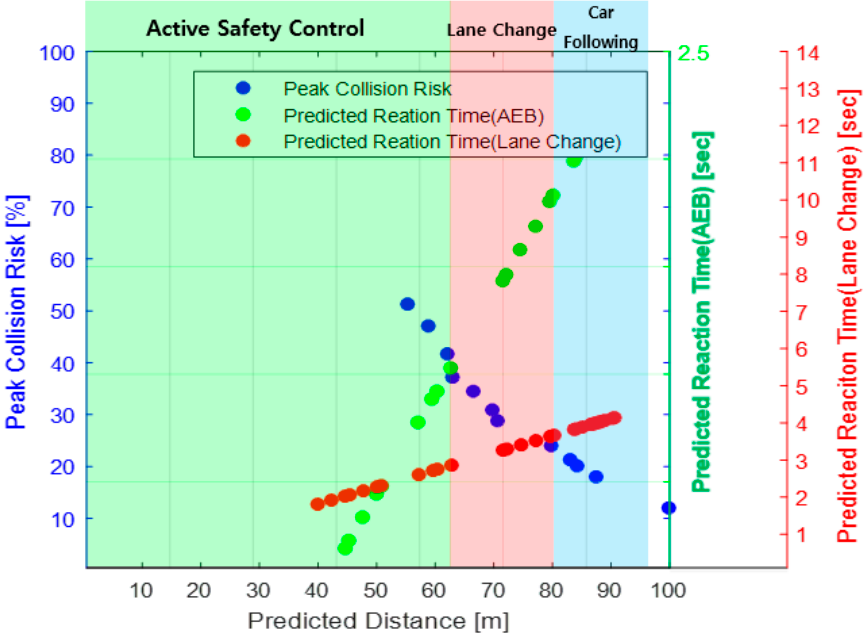
Figure 5. Human Centered Risk Assessment-based Safe Triangle Analysis.